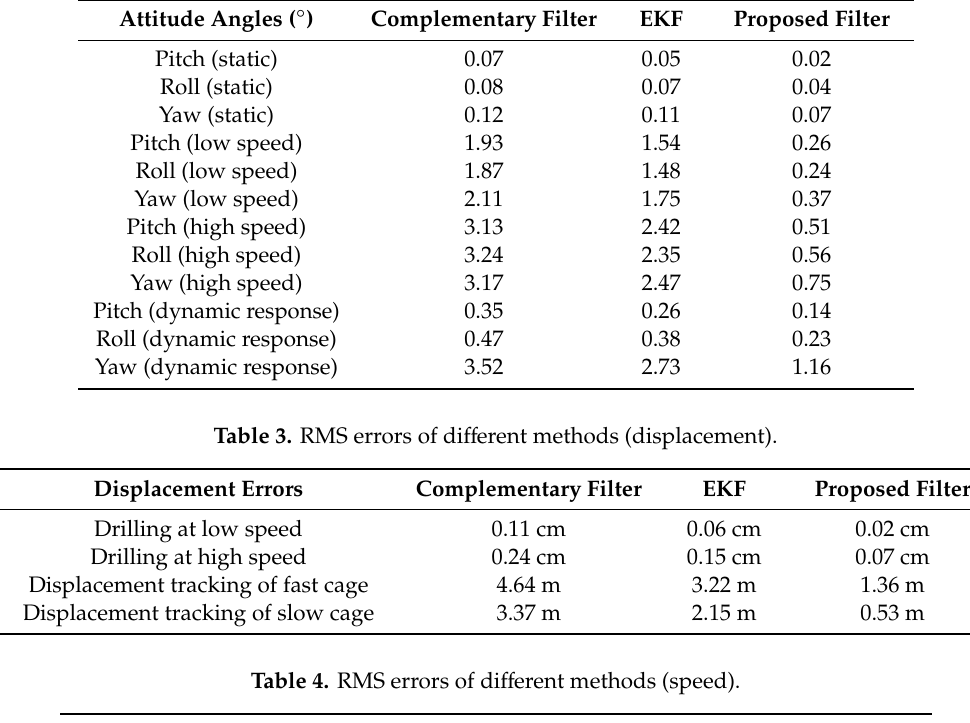
Table 2. RMS errors of di ff erent methods (attitude angles).